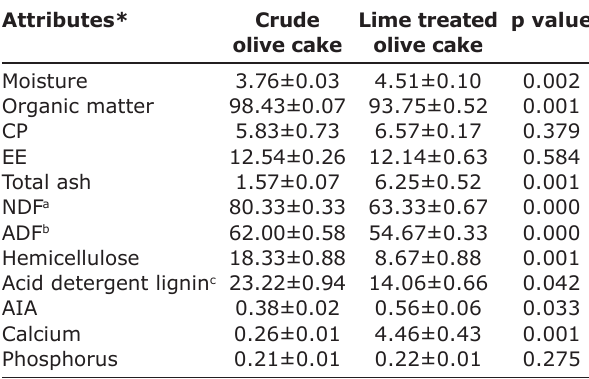
Table-3: Percent chemical composition of Indian crude olive cake and lime treated olive cake Attributes*